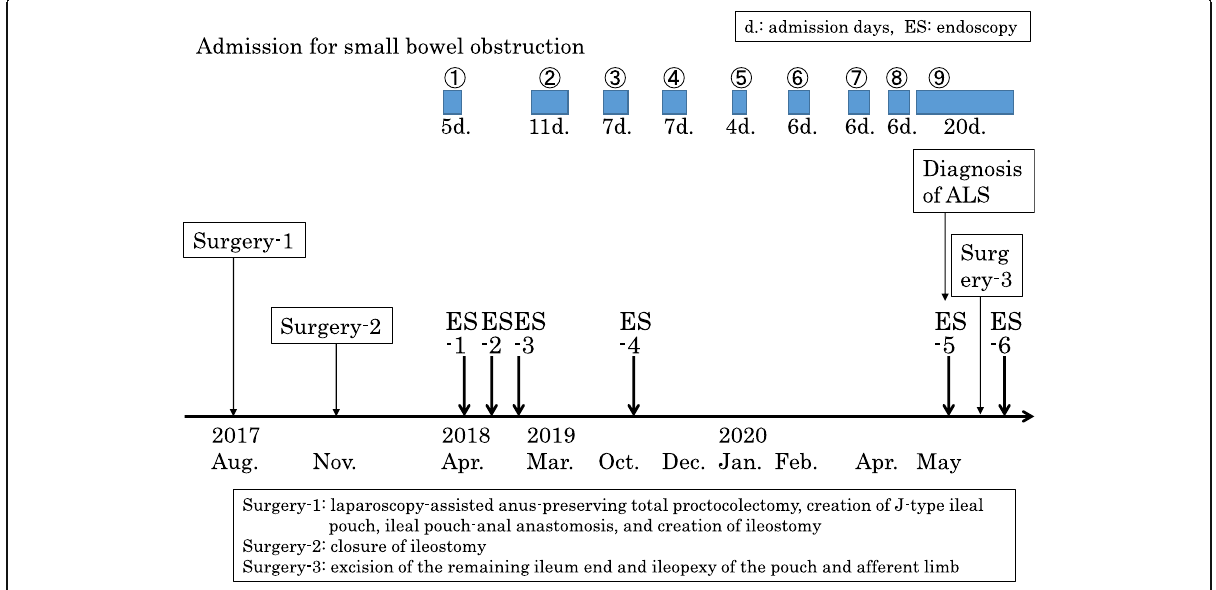
Fig. 1 Clinical course after the patient ’ s first surgery for